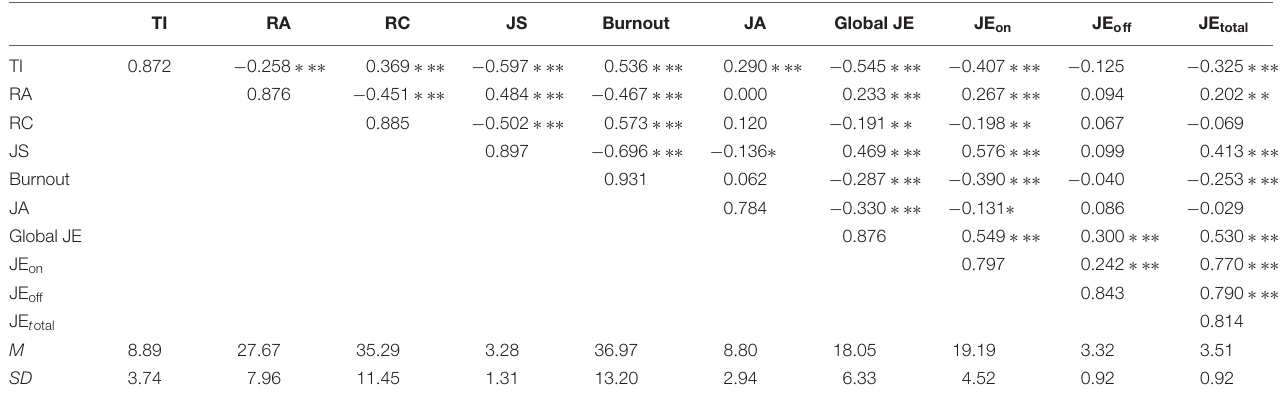
TABLE 2 | Bivariate correlations, scale reliabilities, means, and standard deviations of scales for university staff ( N = 246). TI RA RC JS Burnout JA Global JE JE